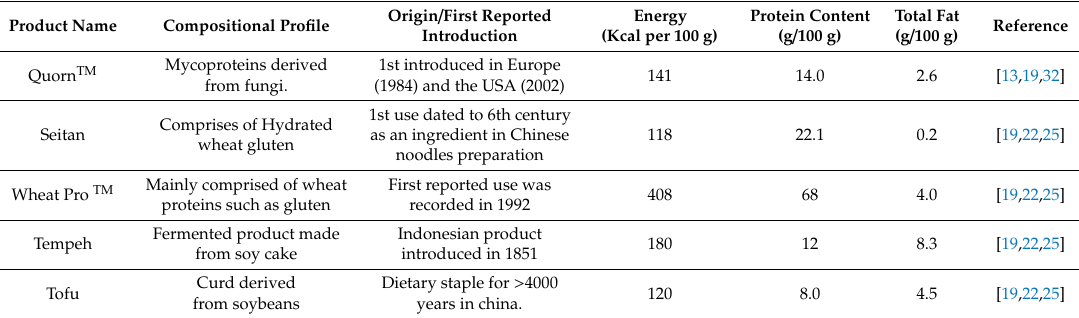
Table 2. Some examples of commercially available plant-based meat